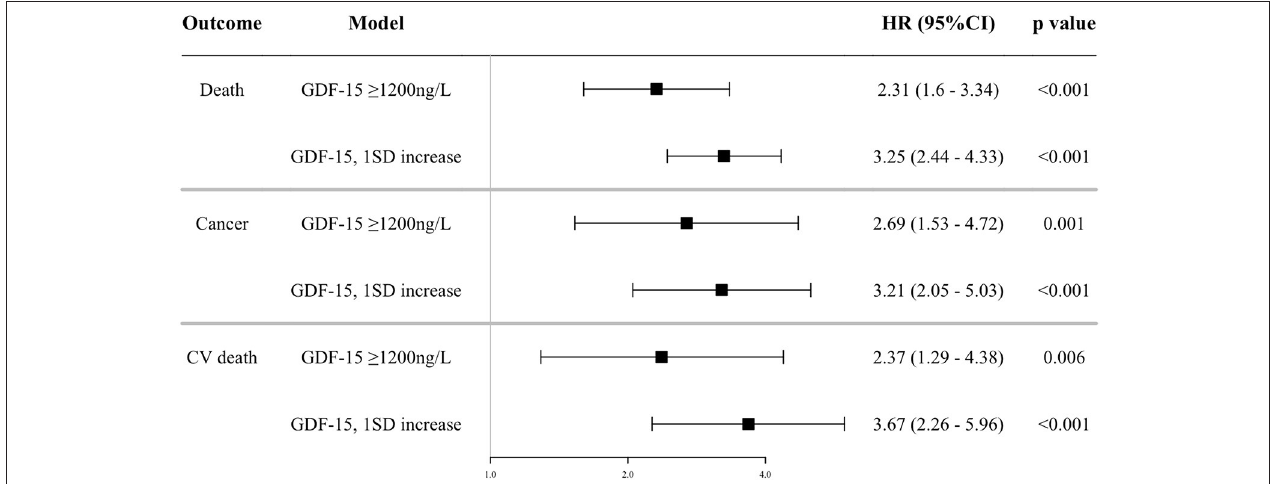
FIGURE 1 | Association between GDF-15 and outcomes. Shown are the results of a Cox proportion hazard analysis by continuous and dichotomous models of GDF-15 and outcomes adjusted for the composite risk score of CV traditional risk factors (age, sex, current smoking, diabetes mellitus, previous CV event, statin use, anti-hypertensive drug use, total cholesterol, high-density lipoprotein cholesterol, office systolic blood pressure), estimated glomerular filtration rate, daily drinker, and high sensitive C reactive protein (log). GDF-15, growth differentiation factor-15; CV death, cardiovascular death; HR, hazard ratio; 95%CI, 95% confidence interval.